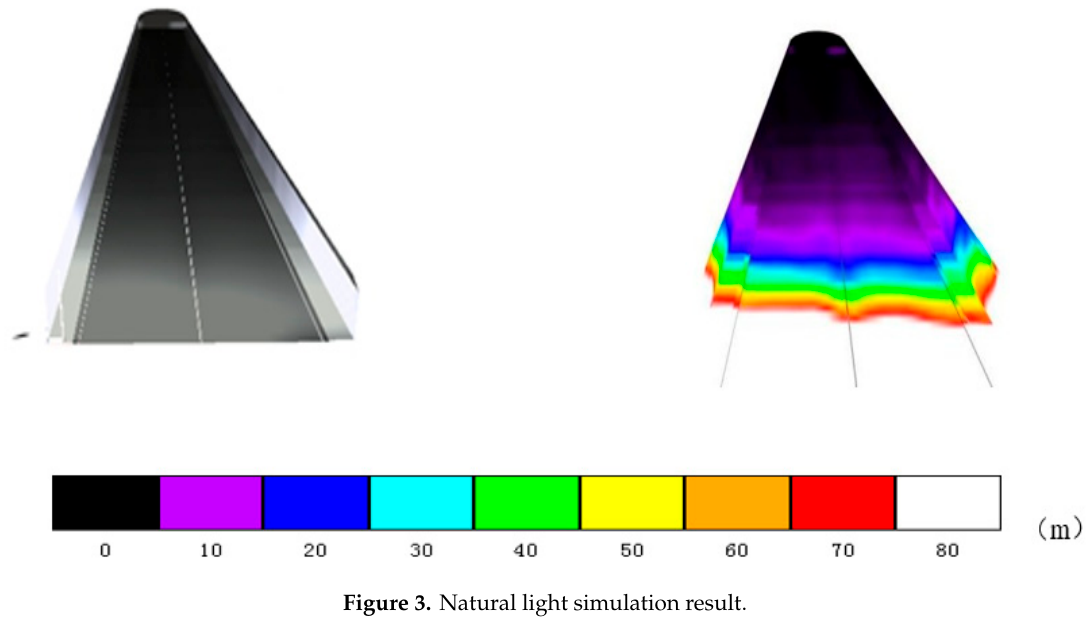
Figure 2. Division of pavement illumination simulation grid.